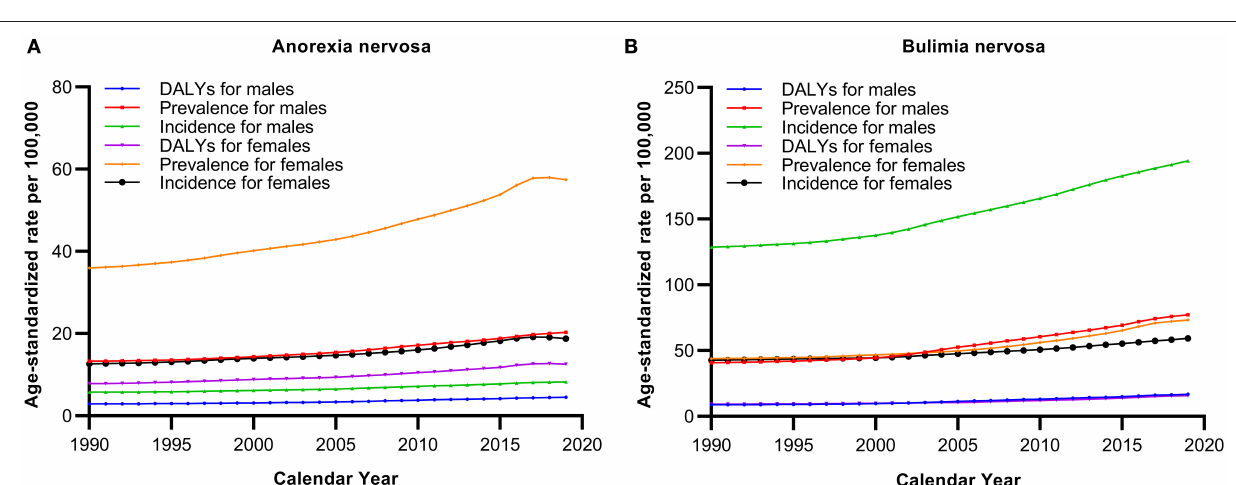
possible to compare regional-level metrics with those in